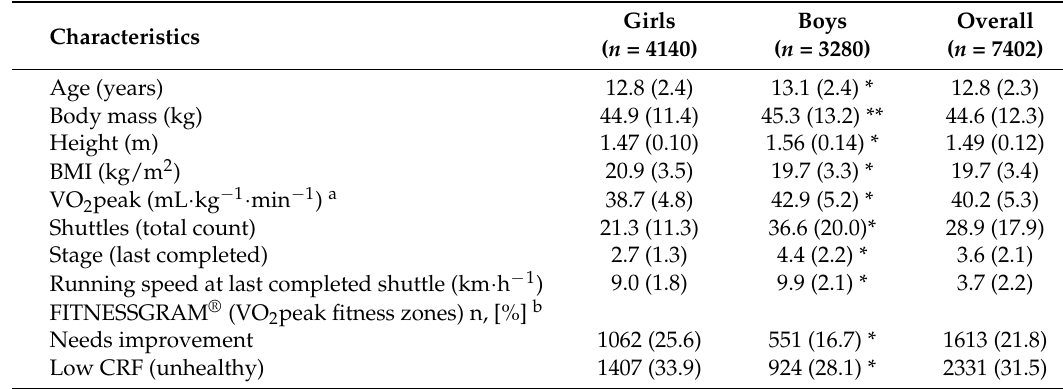
Table 1. Characteristics of among a population-sample of Schoolchildren in Bogota,